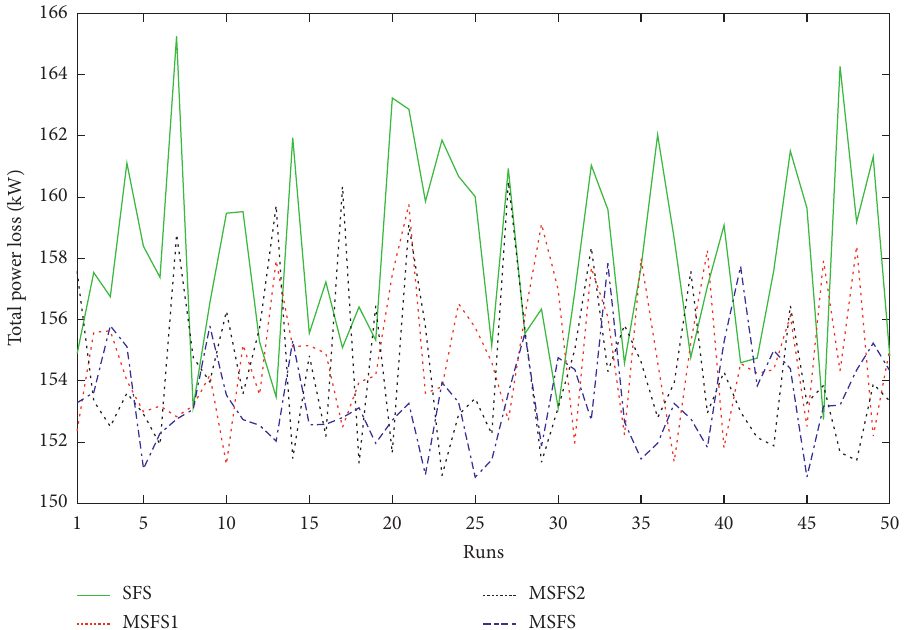
Figure 24: Total power loss of 50 trial runs obtained by SFS methods for case 2 of the 85-bus